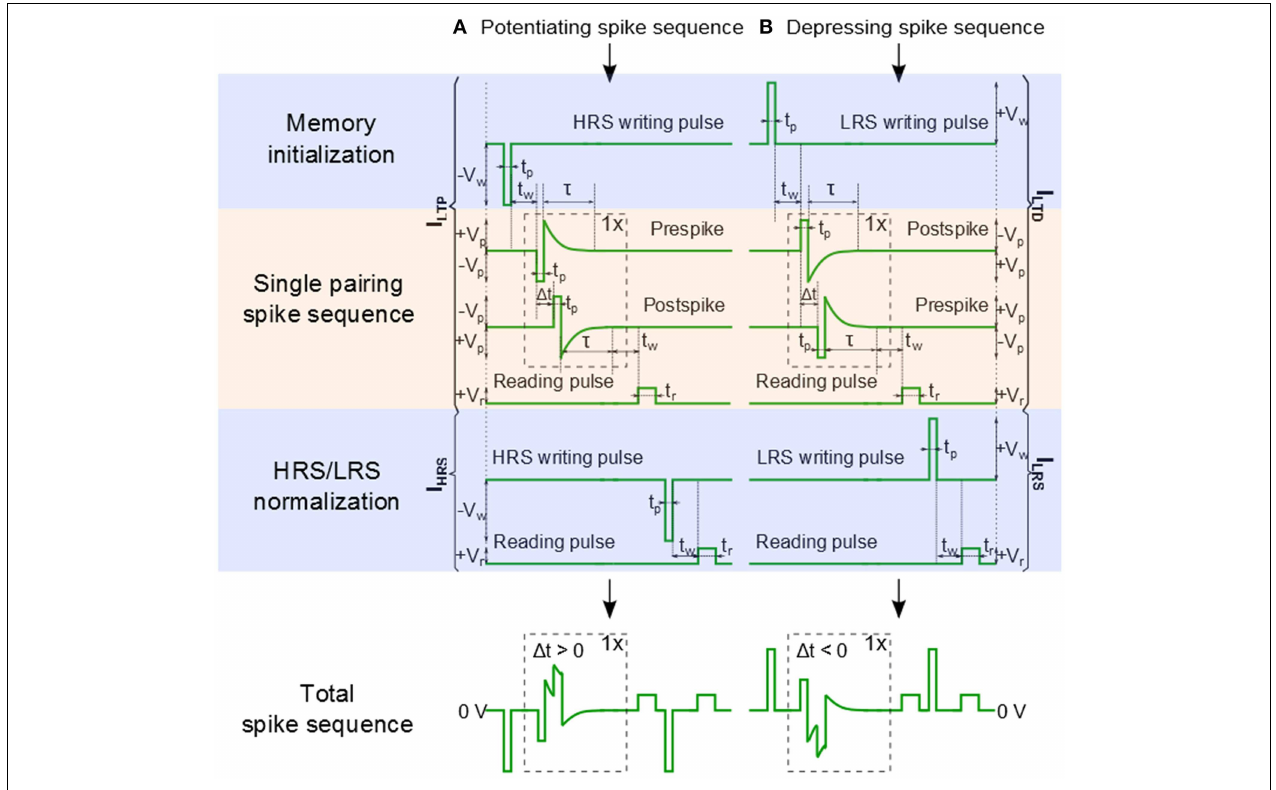
FIGURE 3 | Signal scheme of Memristor initialization, Single pairing STDP, and Memory consolidation. (A) A pre-post spike order is used for long term potentiation (LTP). (B) A post-pre spike order is used for long term depression (LTD). The potentiation current I LTP (depression current I LTD )and